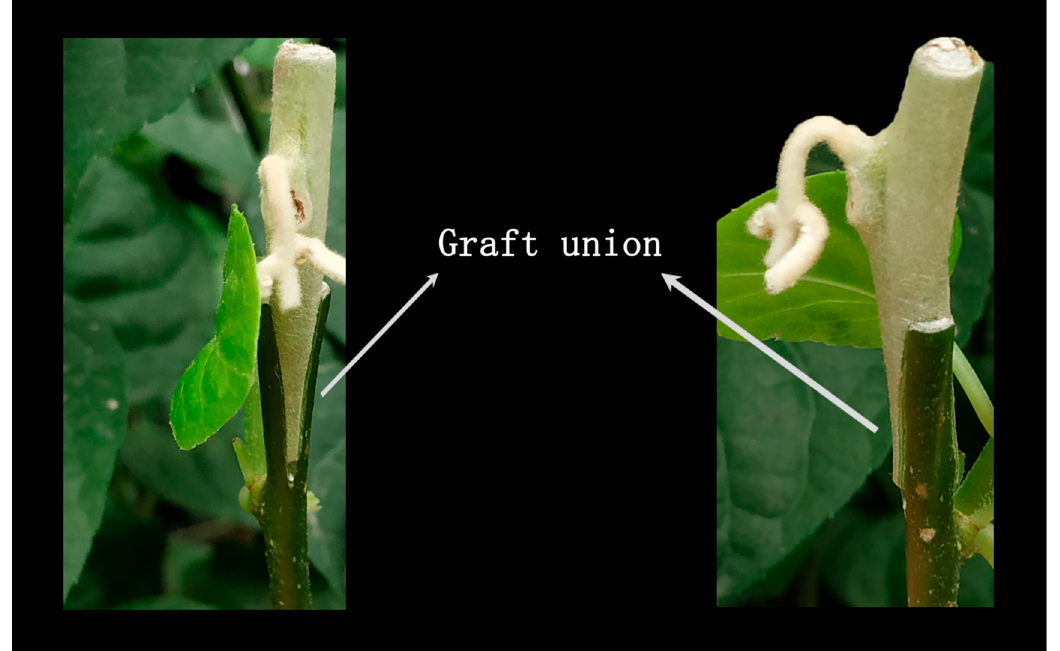
Figure 9. Growth status of scions after removing